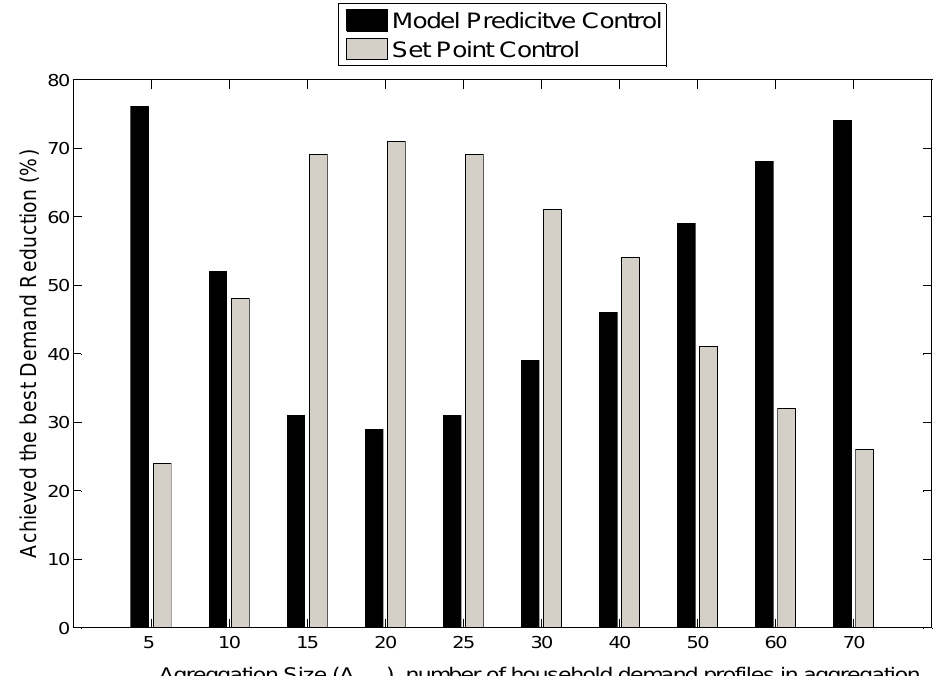
Figure 8. Set-point control and MPC performance when varying the number of demand profiles